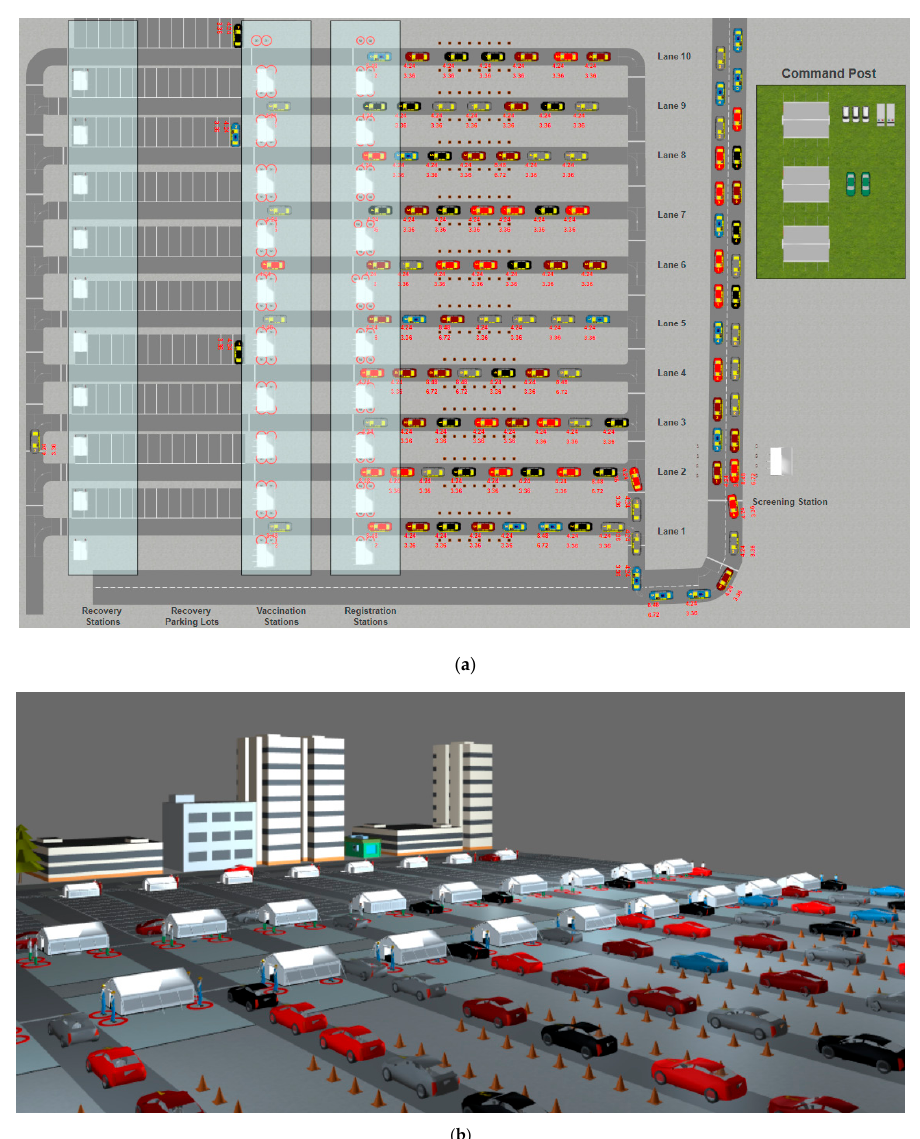
Figure 1. The 2D layout ( a ) and 3D ( b ) of the drive-through mass vaccination simulation tool (available at: https://cloud.anylogic.com/model/583c2075 ‐ 6a8b ‐ 41be ‐ 8a03 ‐ d692eba71683). The discrete event model of the drive ‐ through simulation generates the service pro ‐ cess for each lane from registration to recovery (Figure 2). Start and end time in each sta ‐ tion is measured through time blocks (for example, timer and timeRe refer to the start and end time for registration respectively).